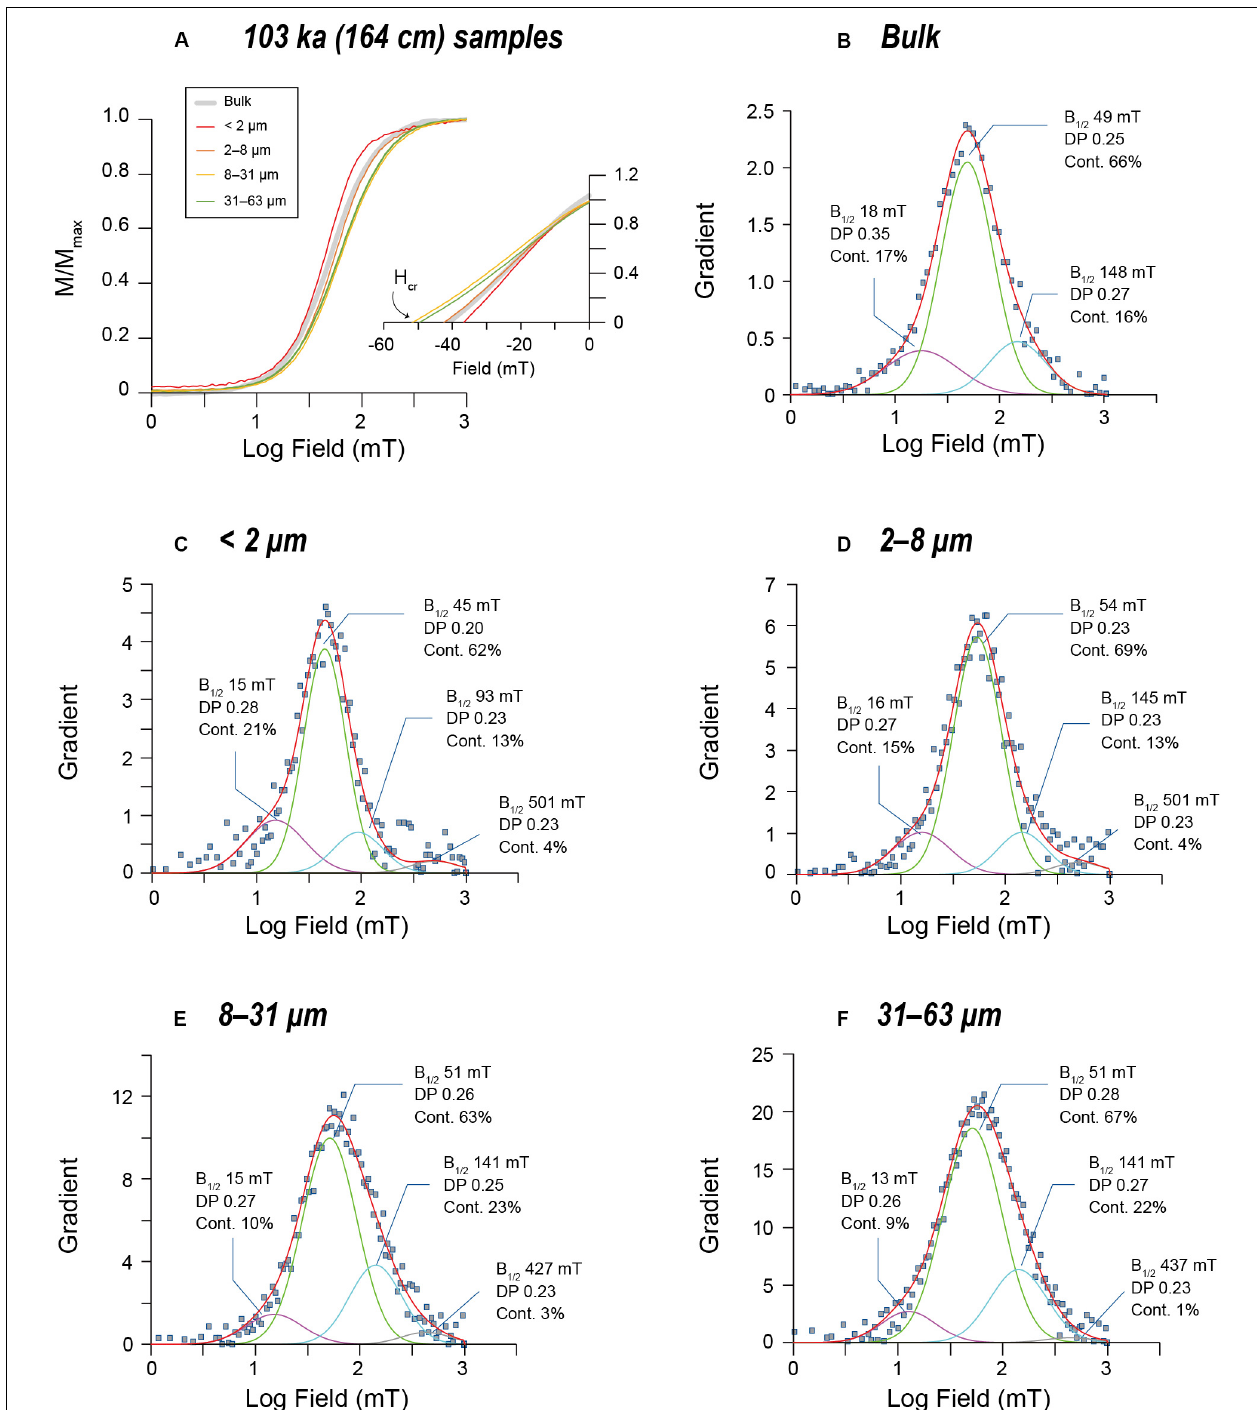
FIGURE 8 | Remanence acquisition and gradient plots for the 103 ka (164 cm depth) samples. (A) IRM acquisition and backfield decay curves for bulk and sized fractions altogether; (B–F) coercivity spectra of bulk and each sized fractions. In coercivity spectra, raw data points are indicated by squares; coercivity components are marked as purple (component 1), green (component 2), blue (component 3), and gray (component 4) lines; and sum of components are red lines fitted to the raw data. For each coercivity component, mean coercivity (B 1 / 2 ), dispersion parameters (DP), and contribution to SIRM (cont.%) are specified.